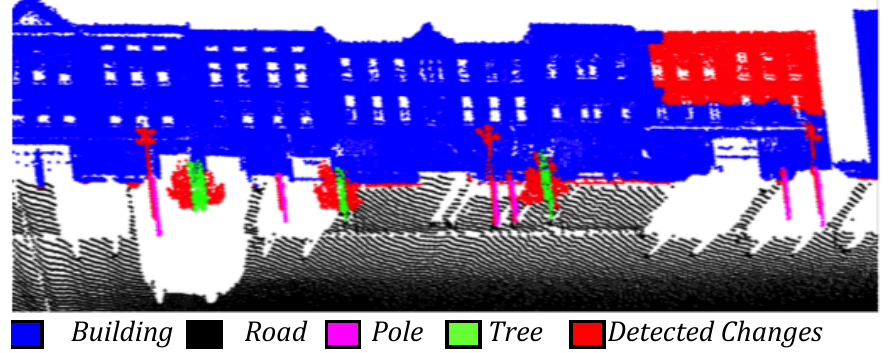
red. These changes were due to a demolished building wall, larger poles cut in half and trimming/cutting of bushes/trees in the